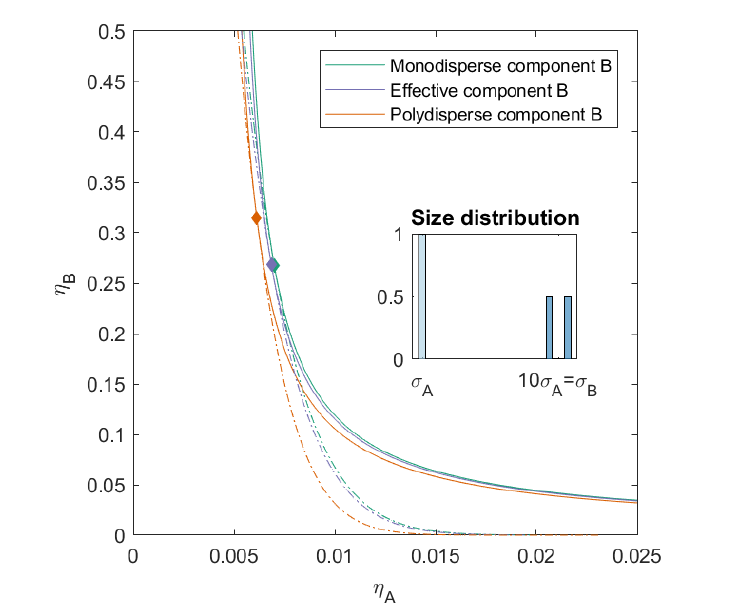
Figure 4. Phase diagram for binary (component A and B ) additive hard sphere mixture with size ratio q = σ A / σ B = 1/10, component A is monodisperse, component B is polydisperse (see size distribution, SD twice of mixture in Figure 3), with a number average size 10 times the size of component A , plotted as a function of the partial packing fractions, η A and η B . The spinodal (solid line) and binodal (dashed line) meet each other at the critical point